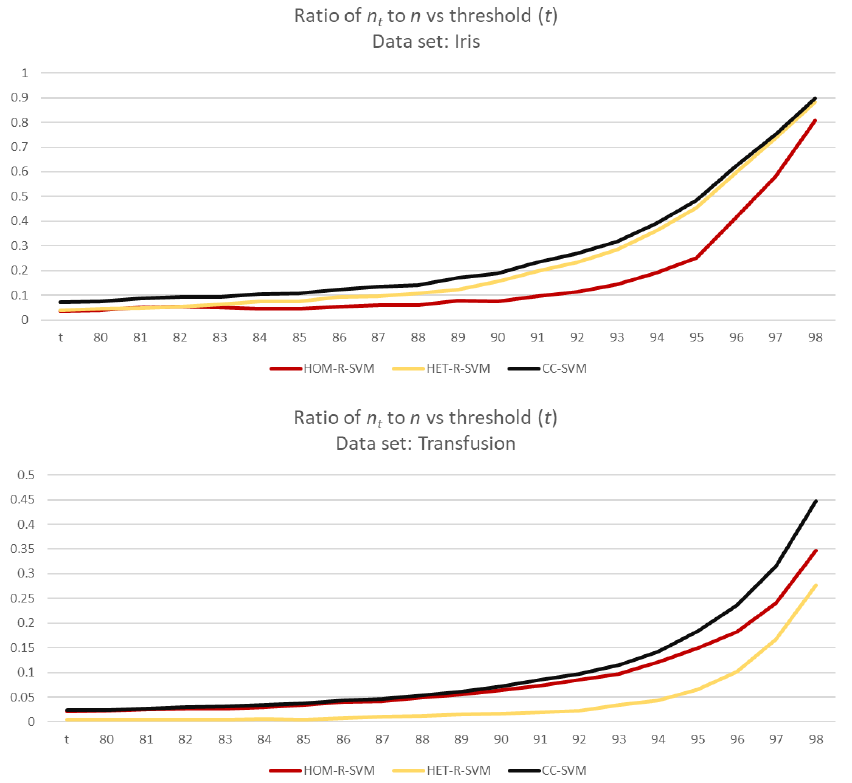
Figure 11. Analysis for ratio of reduction for Iris and Transfusion data